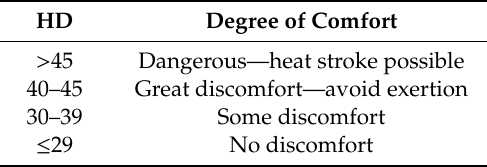
Table 1. Degree of comfort according to Humidex (HD) [46].